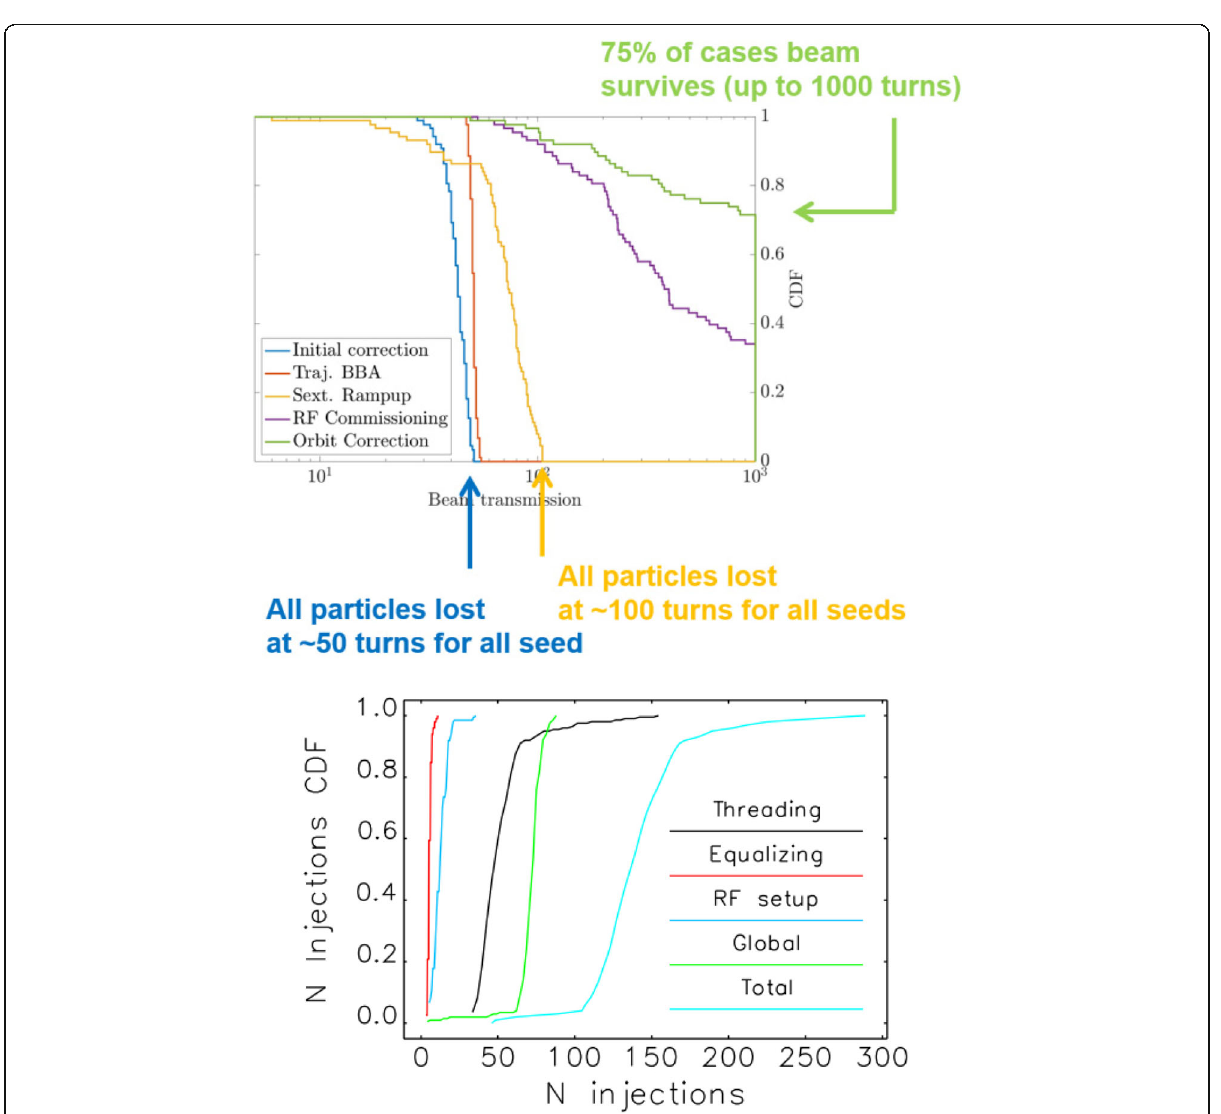
Fig. 13 (Top) Example of commissioning simulations developed for PETRA-IV [25]. (Bottom) Example of commissioning simulations developed for APS-U